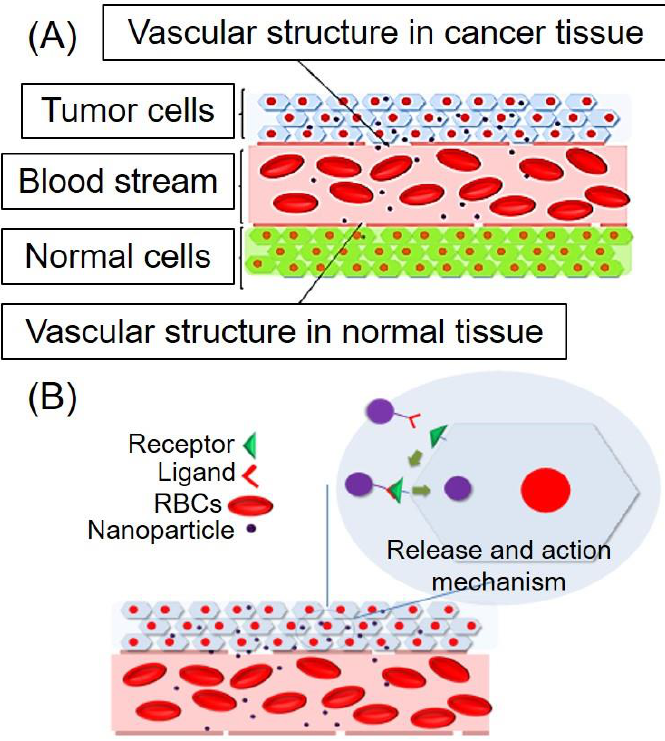
Figure 1. Schematic presentation of drug targeting by ( A ) enhanced permeability and retention (EPR) effect and ( B ) active targeting using tumor-targeted ligands. effect and ( B ) active targeting using tumor-targeted